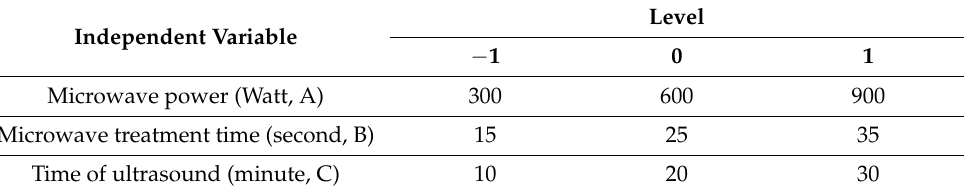
Table 1. Values of independent variables and corresponding proportions utilized in the RSM.